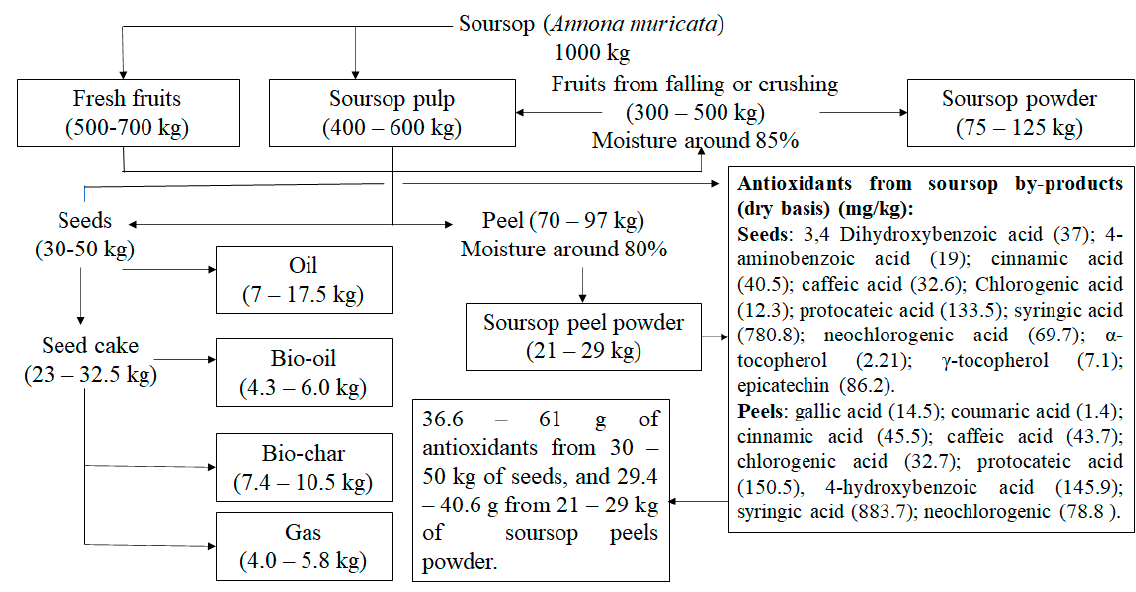
Figure 2. Projection for the simplest applications for the residues of the soursop production chain.